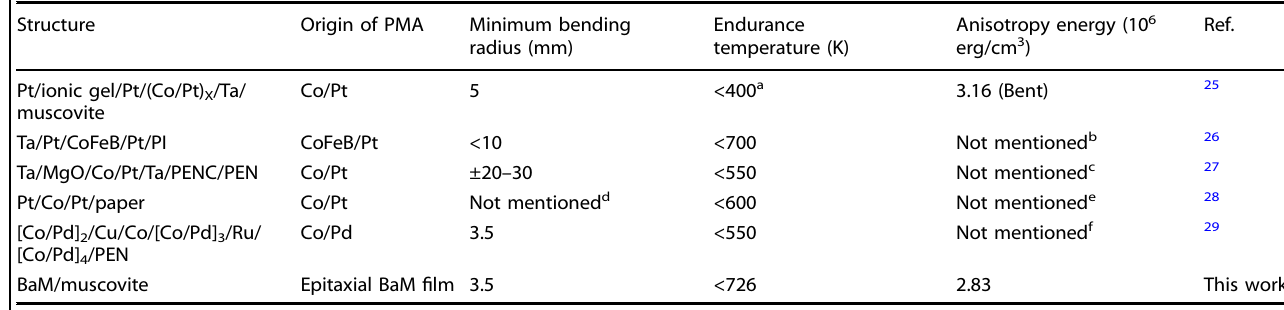
Table 2. Comparison of fl exible PMA